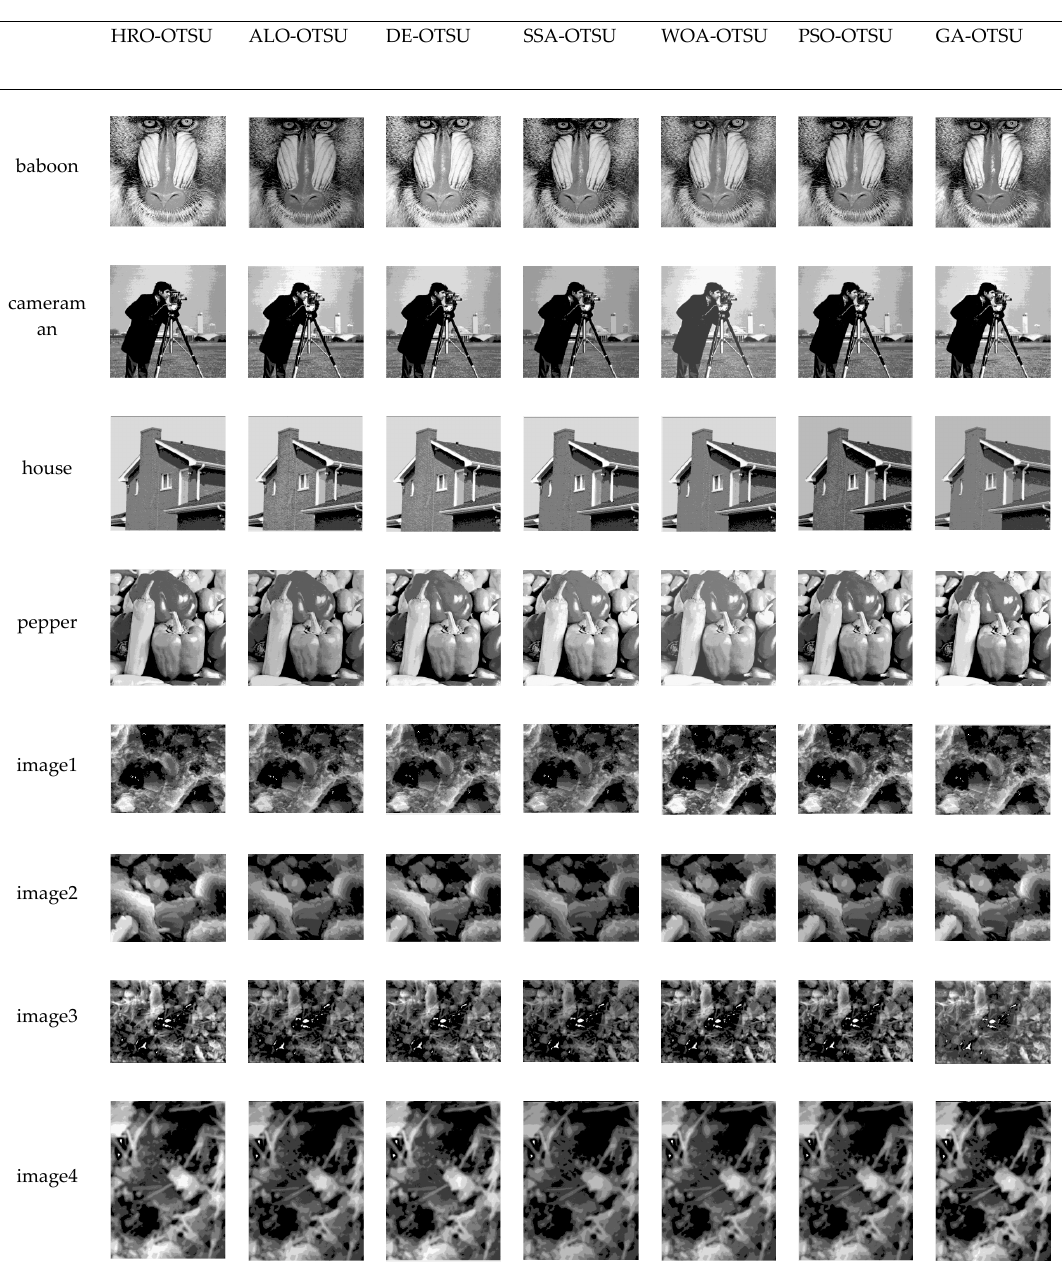
Figure 6. Segmented image obtained from the methods of HRO-Renyi, DE-Renyi, PSO-Renyi, SSA- Renyi, ALO-Renyi, WOA-Renyi, GA-Renyi.